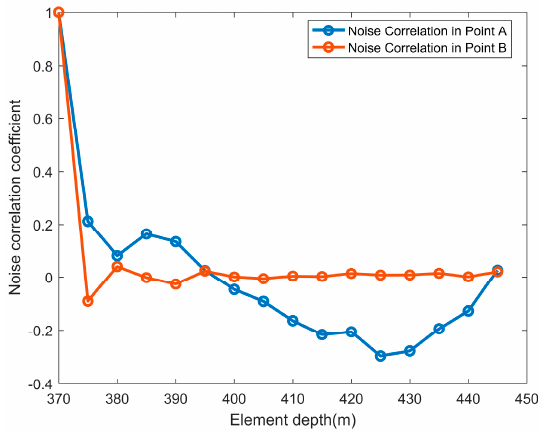
Figure 25. Noise correlation in point A and B.